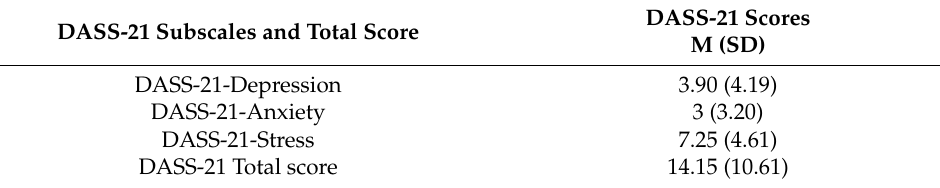
Table A3. DASS-21 scores obtained by patients with